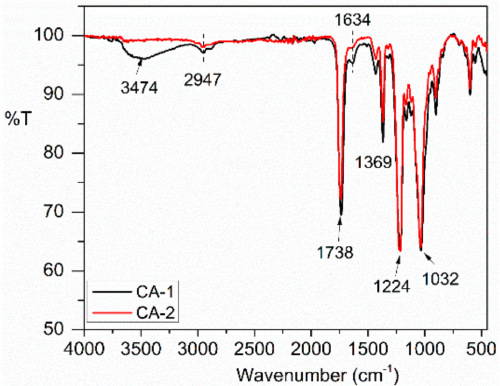
Figure 2. FT-IR of cellulose acetates (CA-1 and CA-2) synthesized from CE-1 and